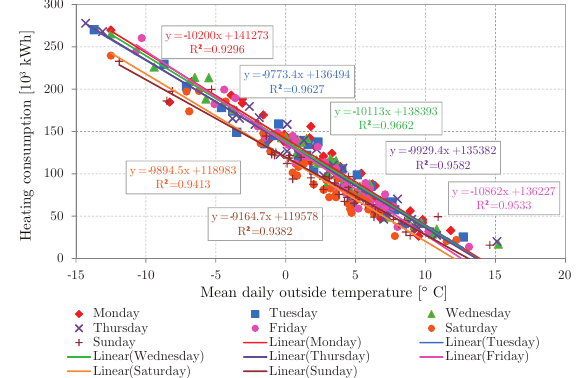
Figure 5: Correlation of the daily heating energy con- sumption with mean daily outside tempera- ture for the year